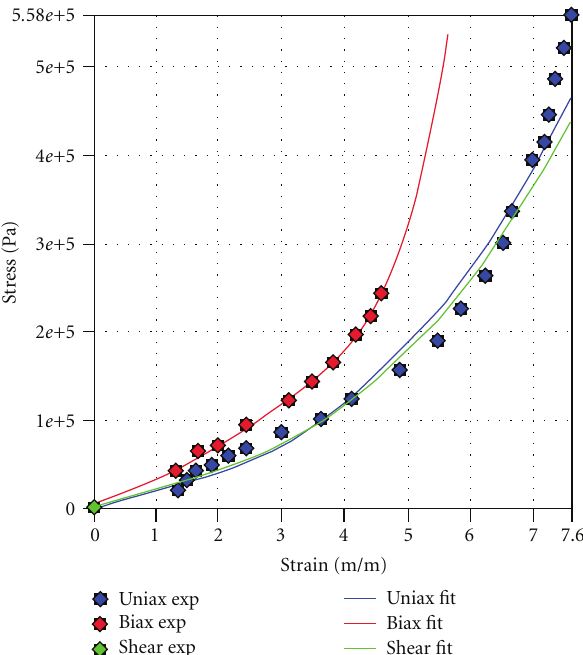
Figure 19: Mooney-Rivling 5 parameter constitutive equation used within the ANSYS 10 shows very close prediction of the rubber sample behavior. It means that Mooney-Rivling 5 parameter can be safely used for the Finite element